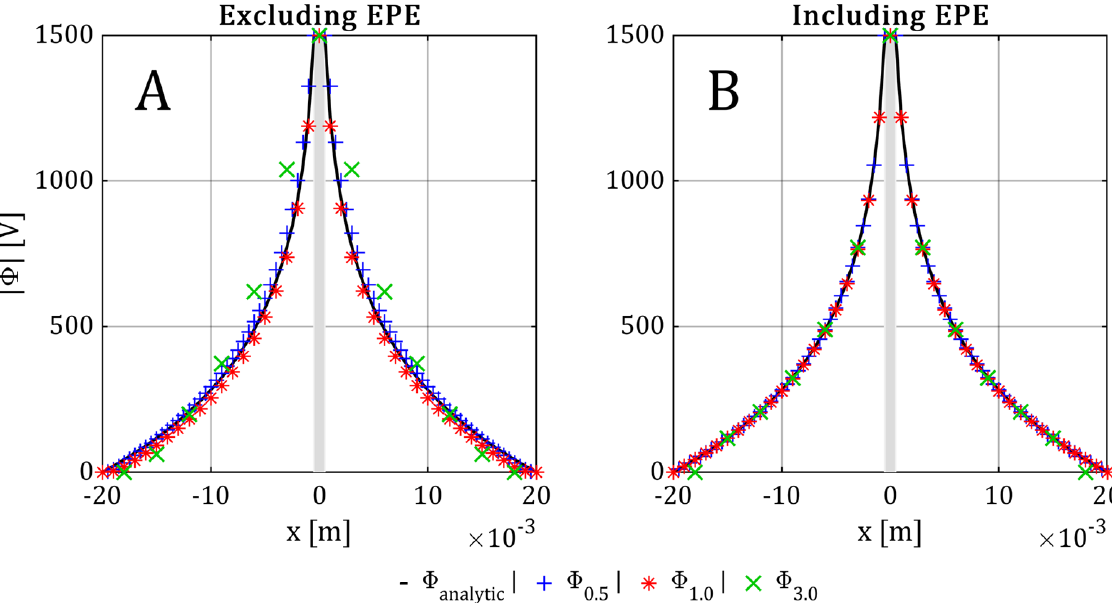
Figure 6. The absolute electric-potential distributions of a coaxial cable model (central grid) along the x-axis excluding/including the Electric-Potential Estimation (EPE). The electric-potential distributions were calculated analytically (black line), and numerically with voxel sizes 0.5 × 10 − 3 m, 1.0 × 10 − 3 m, and 3.0 × 10 − 3 m (colored symbols). In ( A ) EPE was excluded, while in ( B ) EPE was included. The grey bar illustrates the inner electrode of the coaxial cable.